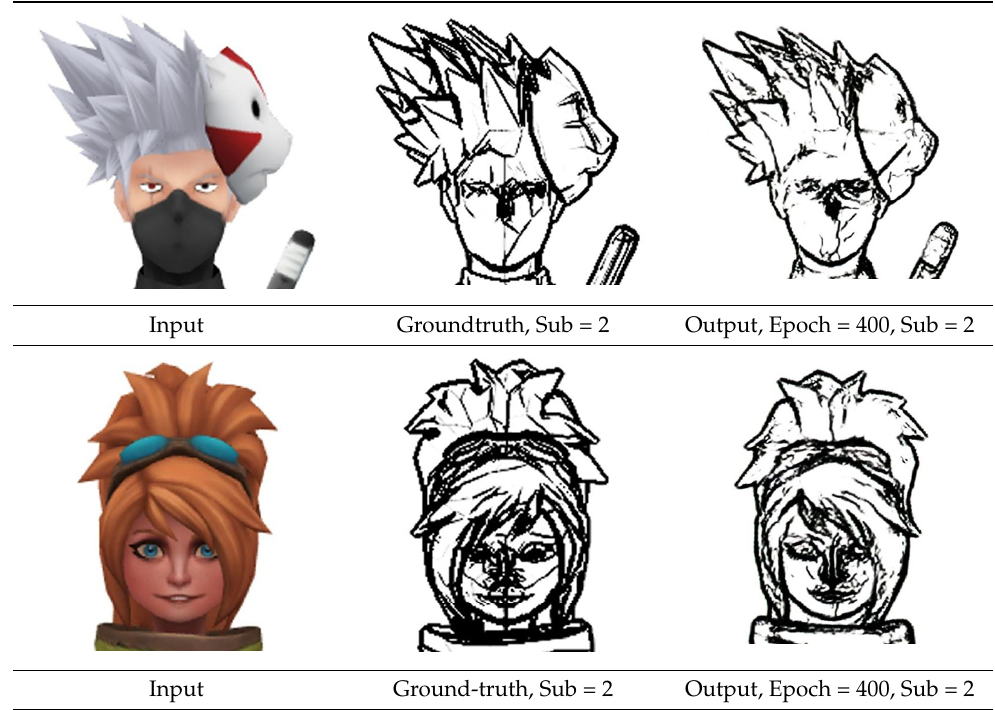
Table 7. Result of the line drawing extraction using a conditional GAN using the face region.